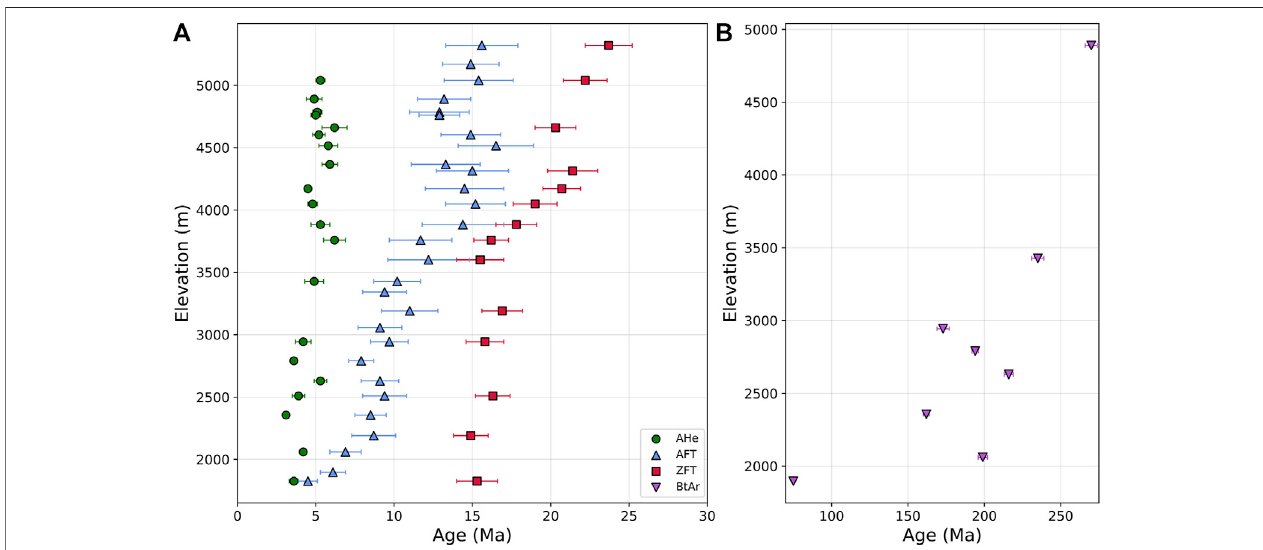
FIGURE 7 | Age-Elevation data from the Xuelongbao Massif analyzed in this study. (A) Apatite (U-Th)/He (AHe), Apatite Fission Track (AFT), and Zircon Fission Track (ZFT) data (with 1 σ uncertainties). (B) Biotite Ar/Ar (BtAr) data (with 2 σ uncertainties).